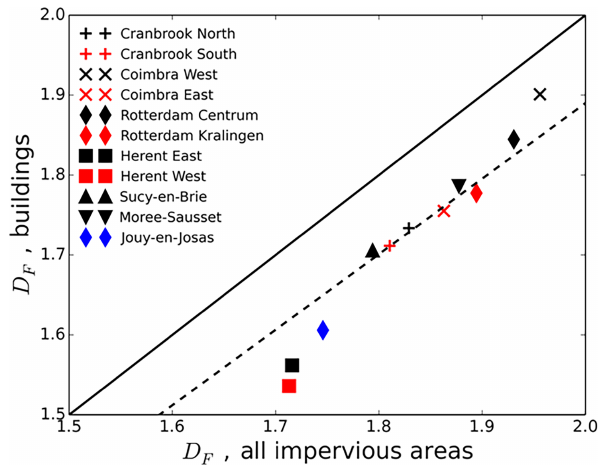
Figure 11. Empirical relation between the fractal dimensions of the total impervious area and of buildings only. The continuous line indicates the first bisector, while dotted line is given by D F 0 . 945 D F a ll